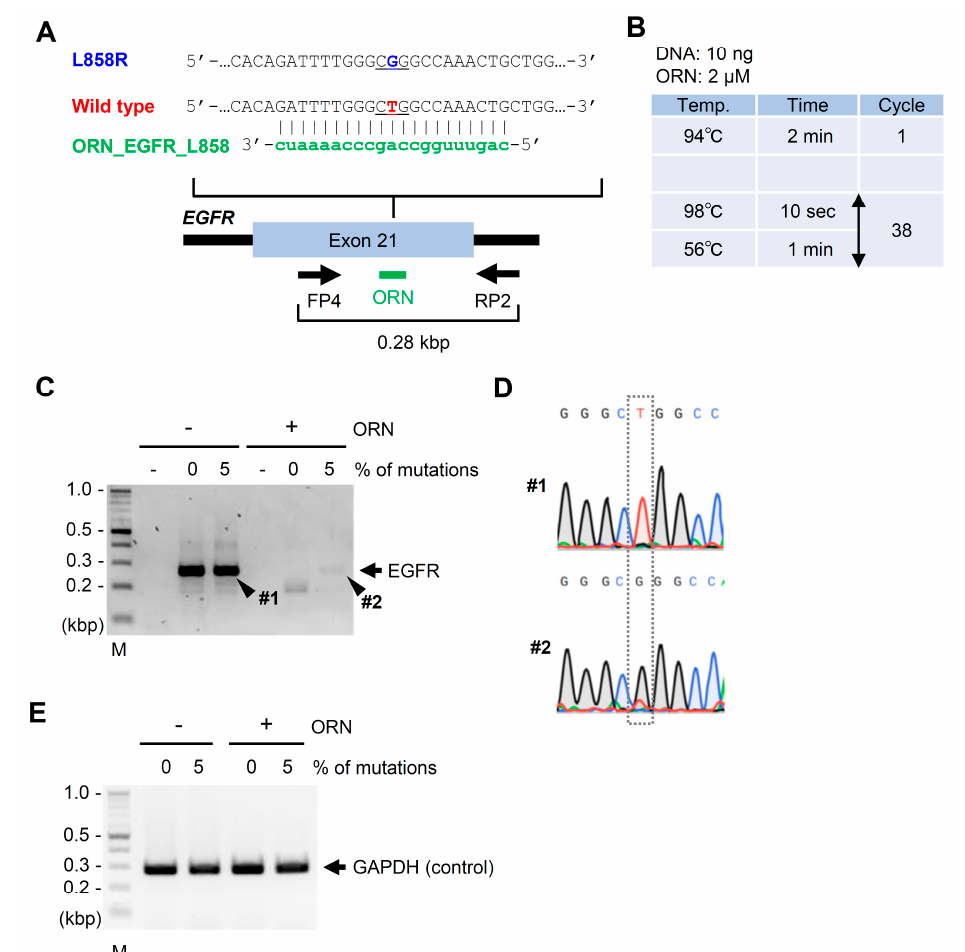
Figure 3. ORNi-PCR using DNA extracted from FFPE specimens to discriminate mutation of the EGFR gene. ( A ) Positions of primers and an ORN targeting a mutation corresponding to EGFR L858R in the human EGFR gene. Arrows indicate forward and reverse primers for amplification of the target region. ( B ) Experimental conditions for ORNi-PCR. ( C ) Results of ORNi-PCR. M—molecular weight marker. ( D ) Results of DNA sequencing analysis. ORNi-PCR (#2) and PCR (#1) amplicons shown in ( C ) were subjected to DNA sequencing analysis. Sequencing signals around the mutation are shown. ( E ) Results of ORNi-PCR targeting the irrelevant GAPDH